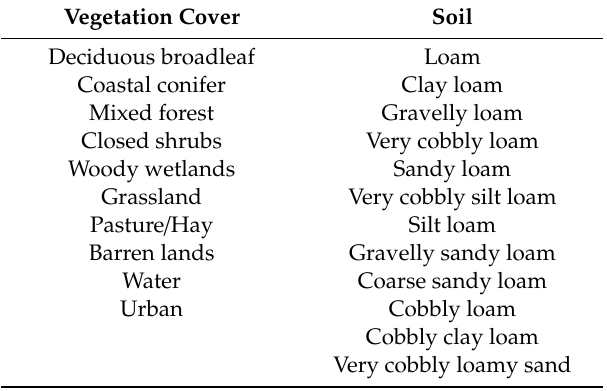
Table 1. Di ff erent types of vegetation cover and soil available in six Jordan River Watersheds.